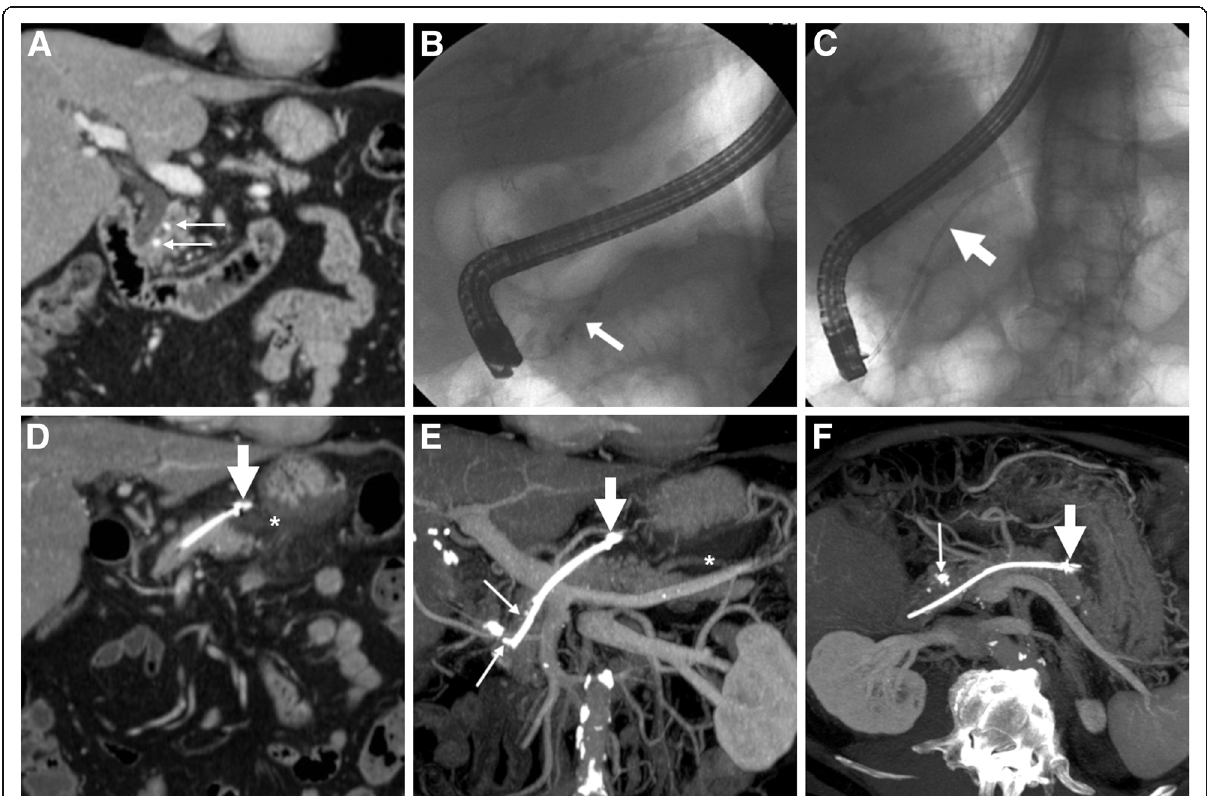
Fig. 6 In a 68-year-old male with CP, oblique-coronal contrast-enhanced MDCT image ( a ) showed two tiny calcifications (thin arrows) at the cephalic tract of the MPD, a finding confirmed during endoscopic retrograde cholangiopancreatography (ERCP, b — MPD indicated by arrow) and treated by positioning of a long pancreatic stent (thick arrow in c ). Repeated MDCT ( d – f ) showed the distal end of the MPD stent (thick arrows) to be located outside the pancreatic gland. Note that excellent depiction of stent (thick arrows) and burden of calcifications (thin arrows) by MIP reconstructions ( e , f ). Despite clinical improvement, the stent had to be